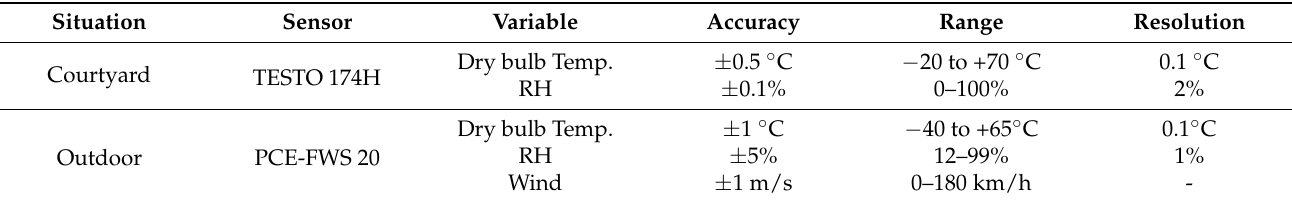
Table 1. Technical data of the measurement